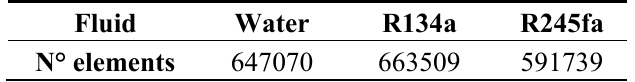
Table 3. Number of triangular elements for FEM